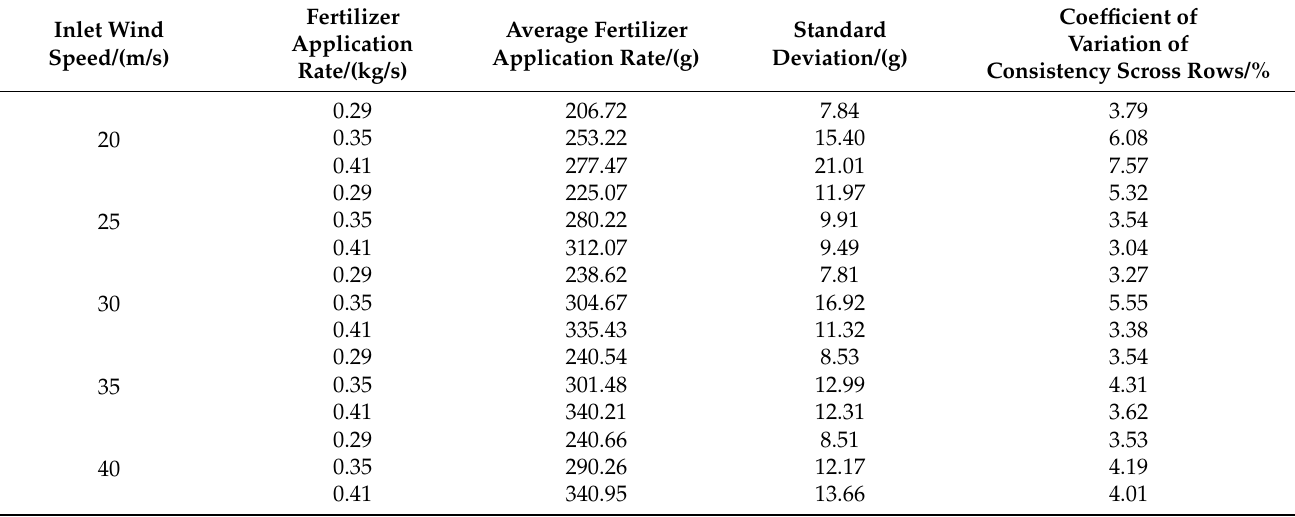
Figure 9. Air flow analysis diagram in conveying pipe ( a ) Local air velocity vector of fertilizer conveying pipe; ( b ) Distribution of local airflow field in fertilizer conveying pipe.